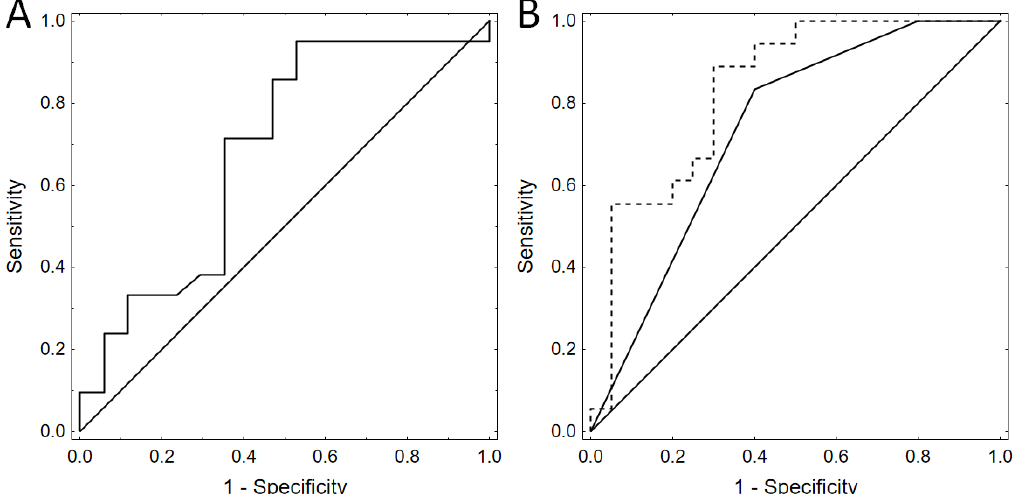
Figure 3. Receiver operating characteristic curves based on backward stepwise logistic regression showed that the best model for delayed cerebral ischemia (DCI) prediction based on clinical markers contained only Hunt and Hess scale (AUC 0.733, 95% CI: 0.572–0.894). When we added to this the model F2-IsoP levels on day 3, we received better results—AUC 0.833, 95% CI: 0.703–0.964. Thus, we improved the outcome prediction ( p = 0.043). The differences remained significant after fivefold cross validation. ( A ) Receiver operating characteristic curves based on backward stepwise logistic regression models designed with resampling and cross-validation procedure. Prediction of delayed cerebral ischemia (DCI) by Hunt and Hess scale alone. ( B ) Receiver operating characteristic curves based on backward stepwise logistic regression models designed with resampling and cross-validation procedure. Dashed line—prediction of delayed cerebral ischemia (DCI) by Hunt and Hess scale and F2-IsoP levels on day 3; solid line—Hunt and Hess scale alone.